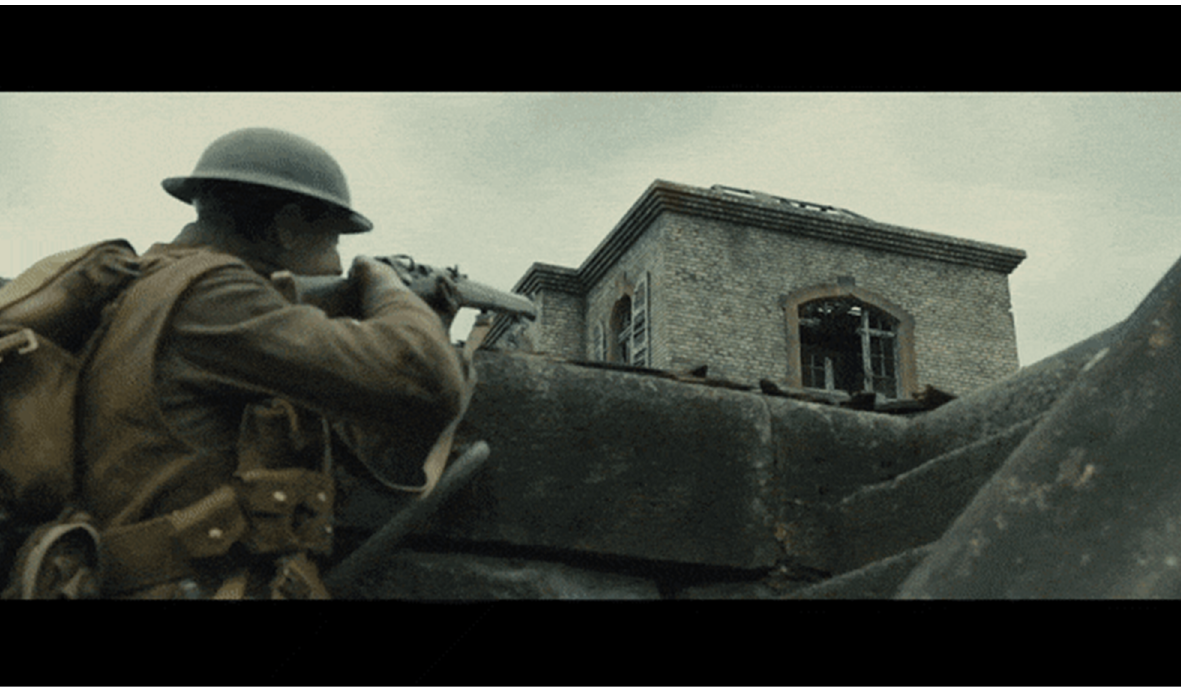
Figure 10. Or fire upon an enemy. (Screenshot created by author).